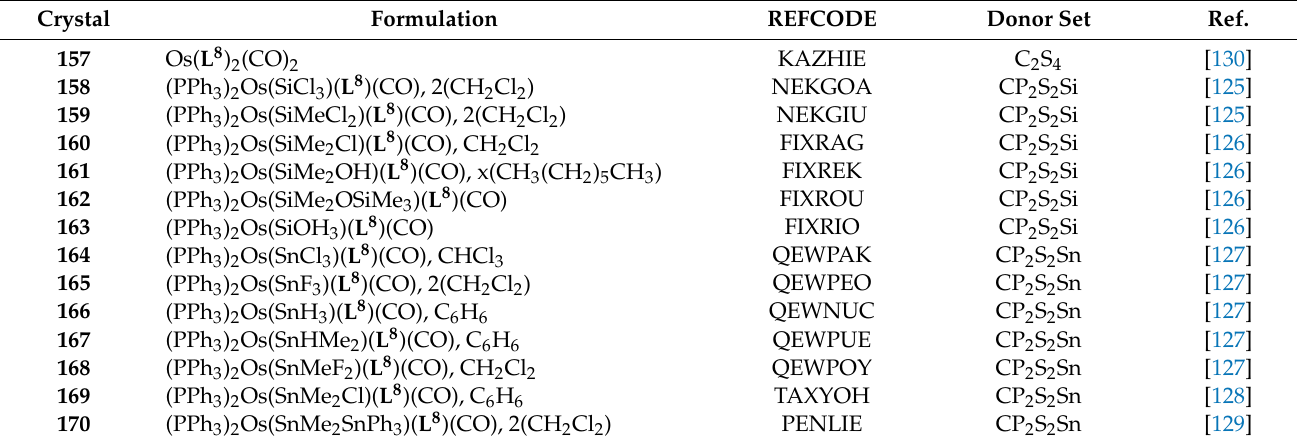
Table 5. Summary of osmium dithiocarbamate structures established by X-ray crystallography. See Table 1, Figure 2, and the Abbreviations section.